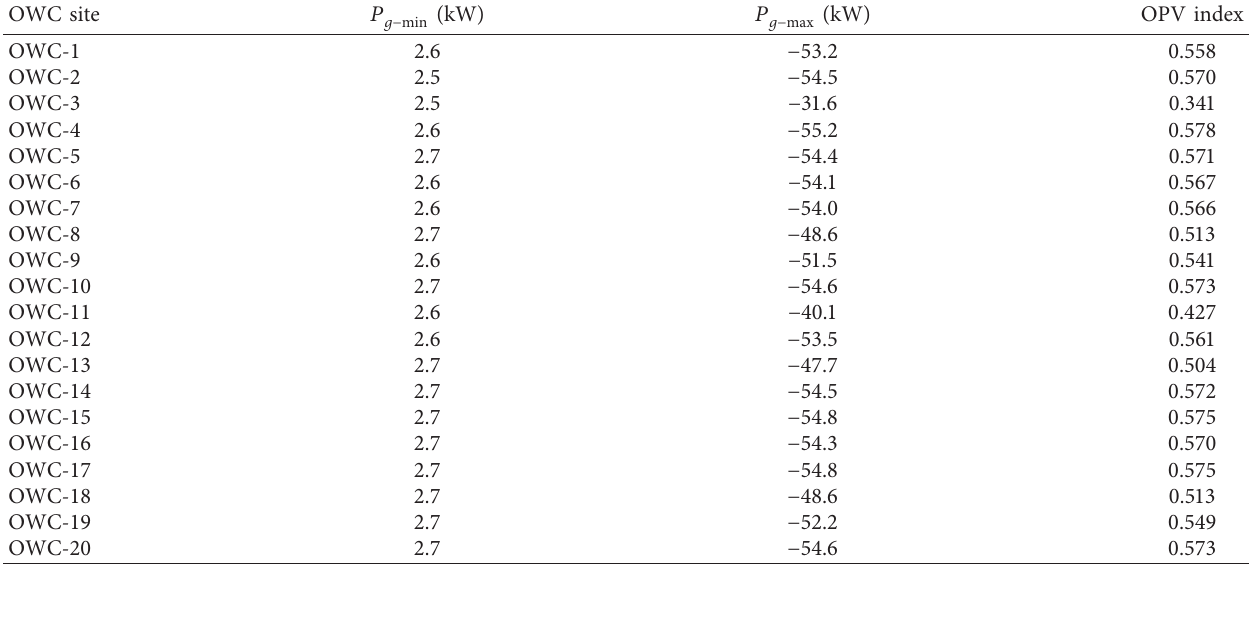
Table 2: OPV index values of individual OWC sites.